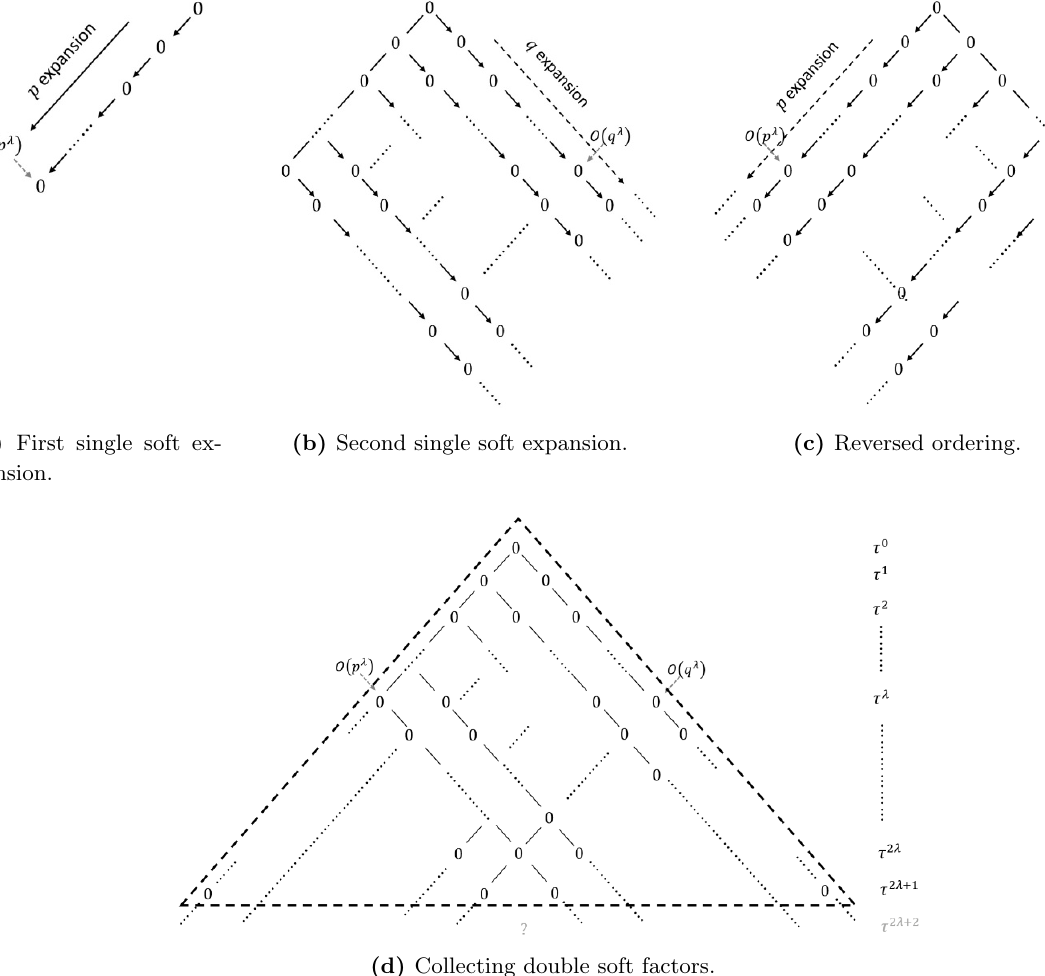
Figure 4. Deriving double soft theorems from vanishing single soft theorems. (a) First single (cid:0) (cid:1) soft expansion, in p , vanishes up to order O p (cid:21) . (b) Second single soft expansion, in q , does not (cid:0) (cid:1) stop at order O q (cid:21) but continues to arbitrary order. (c) Expanding (cid:12)rst in q and then in p gives similar result. (d) Vanishing single soft gives more higher order terms, so double soft theorems can be obtained up to order (cid:28) 2 (cid:21) +1 . Note the comparison with non-vanishing single soft limit, given in (cid:12)gure 2c, which stops at order (cid:28) (cid:21)